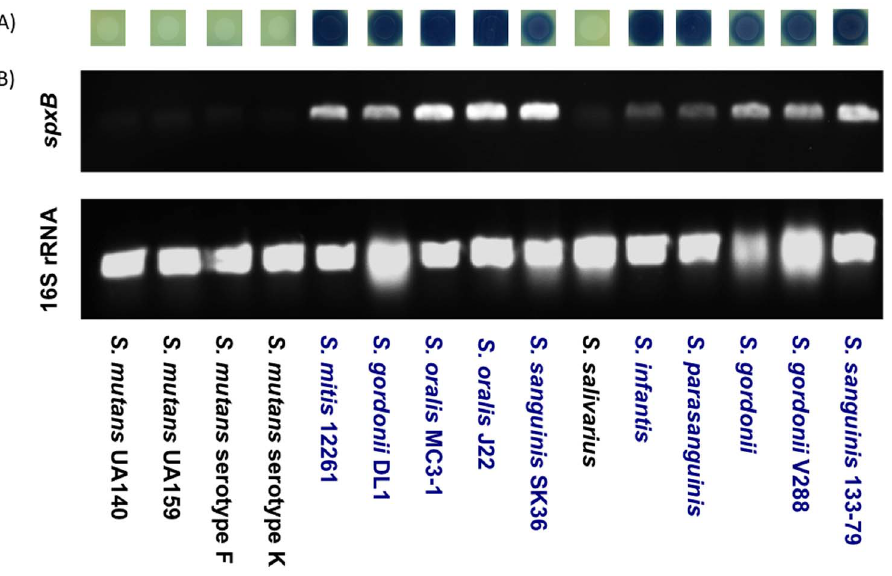
Figure 1. Correlation of H 2 O 2 production and genomic spxB presence. A) H 2 O 2 production assay of common laboratory strains. Cells were spotted on H 2 O 2 indicator plates (Prussian Blue pigment development indicates H 2 O 2 production) and incubated over night under aerobic conditions. Blue color development indicates H 2 O 2 production. B) PCR using universal spxB oligonucleotides. Cells were scraped from the H 2 O 2 indicator plates, grown overnight and chromosomal DNA isolated and used for PCR with universal spxB oligonucleotides. 16S rRNA amplification was